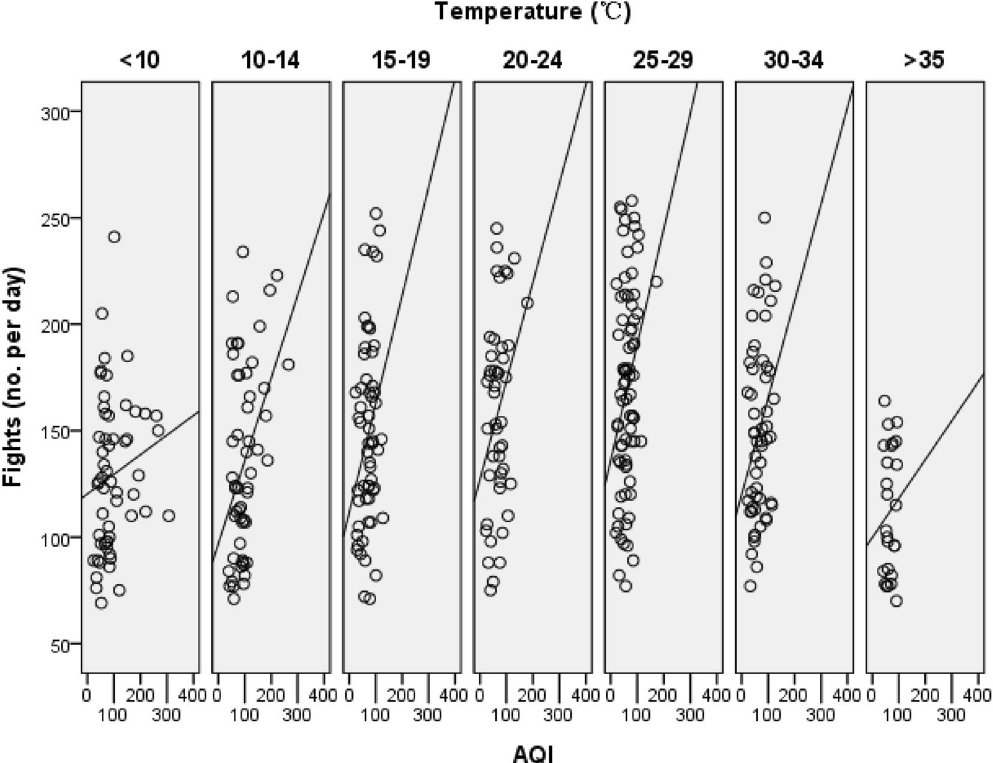
Figure 1. The effect of air quality (AQI) and temperature on social conflict of a captive monkey group in Nanjing Hongshan Zoo in